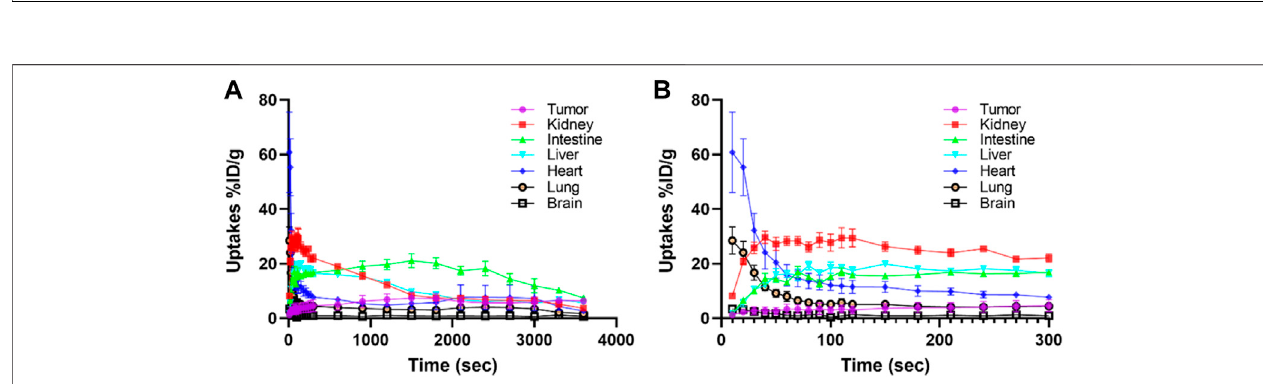
FIGURE 5 | Dynamic time – activity curves of 11 C-RJ1102 in the heart, kidney, liver, brain, lung, Intestine, and tumor in U87MG tumor-bearing nude mice. The difference between (A,B) is the ordinate, for (A) the time is from 0 to 3,600 s. And for (B) the time is from 0 to 300 s.